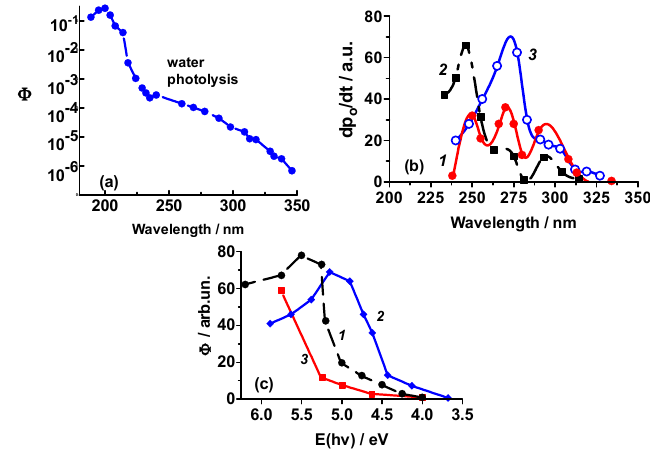
Figure 4. ( a ) Spectral dependences of the quantum yields of the photolysis of water on α -Al 2 O 3 particles. The surface of the solid adsorbent had previously been hydrated by heating the alumina particles in a water vapor atmosphere at 250 °C for 6 h—note the logarithmic plot of Φ ; ( b ) Spectral dependences of the initial rate of the: (1) photodecomposition of water; (2) photoreduction of oxygen; and (3) photodecomposition of ammonia on γ -Al 2 O 3 (from the data reported by Kotel’nikov and Terenin [4]); ( c ) Spectral dependencies of the quantum yields of the photoreduction (photoadsorption) of oxygen on: (1) γ -Al 2 O 3 ; (2) MgO; and (3) BeO [49]. Note: In Ref. [49], the spectral dependencies of Φ were presented in arbitrary units but are nonetheless proportional to the true quantum yields.